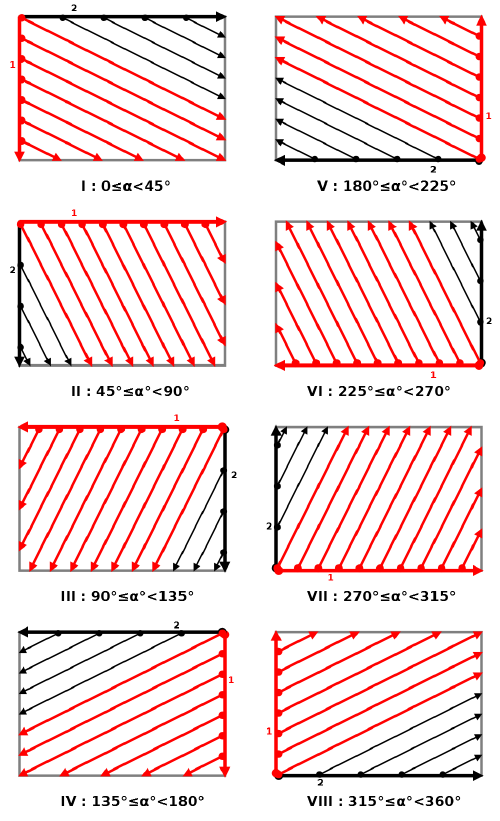
Figure 1. Primary (red) and secondary (black) sweeps over the disparity space image for paths with an arbitrary slope α